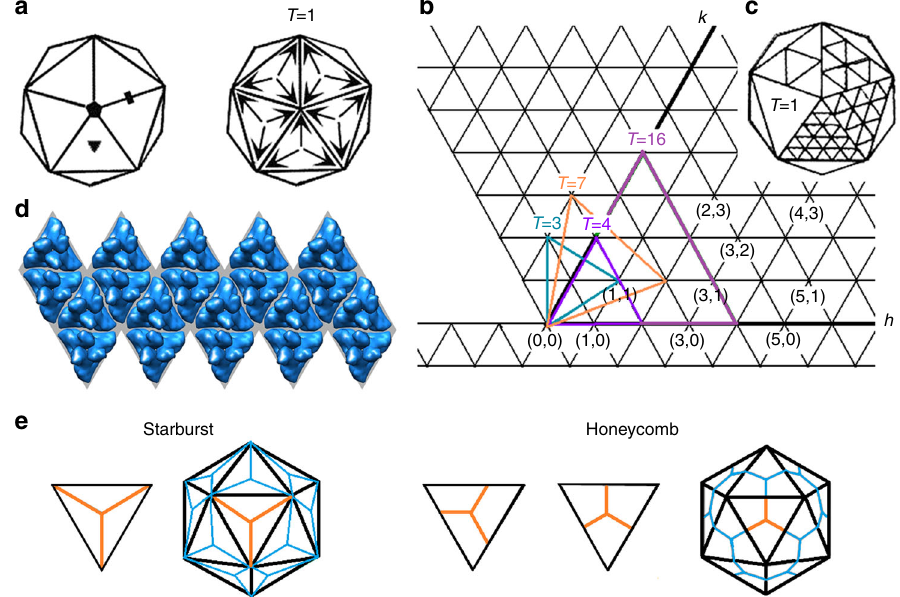
Fig. 1 The geometry of viral capsids. a Schematic representation of an equilateral icosahedron; 20 fl at triangular faces and 12 vertices are arranged around a sphere and related by fi ve-, three- and two-fold axes of rotational symmetry (diamond, triangle and rectangle, respectively). With each triangular face hosting three protein subunits (arrows at the vertices), 60 equivalent subunits in total, the icosahedron becomes a T = 1 capsid. b Equilateral triangular net relating icosahedral and quasi-equivalent symmetries. Each triangulation ( T ) number is calculated from ( h, k ) and denotes the number of smaller triangles arranged around local quasi-6-folds in one triangular icosahedron face. c The net folded into an icosahedron showing different T numbers in individual triangles: (clockwise) 1, 4, 9, 16 and 25. d Native virus ( T = 1) capsid unfolded into a triangular net with three identical subunits in each triangular face. The fi gure (Vdb 898, PDB 2GSY) was obtained from VIPERdb (http://viperdb.scripps.edu) 9 . e Two arrangements of a C 3 -triskelion within a triangular unit leading to “ starburst ” and “ honeycomb ” propagation modes. In the starburst mode, the three equivalent legs of the triskelion serve as the altitudes of the triangle. Two variations of the honeycomb triskelion arrangement, symmetrical and asymmetrical, are given. For clarity, central triskelions are shown in